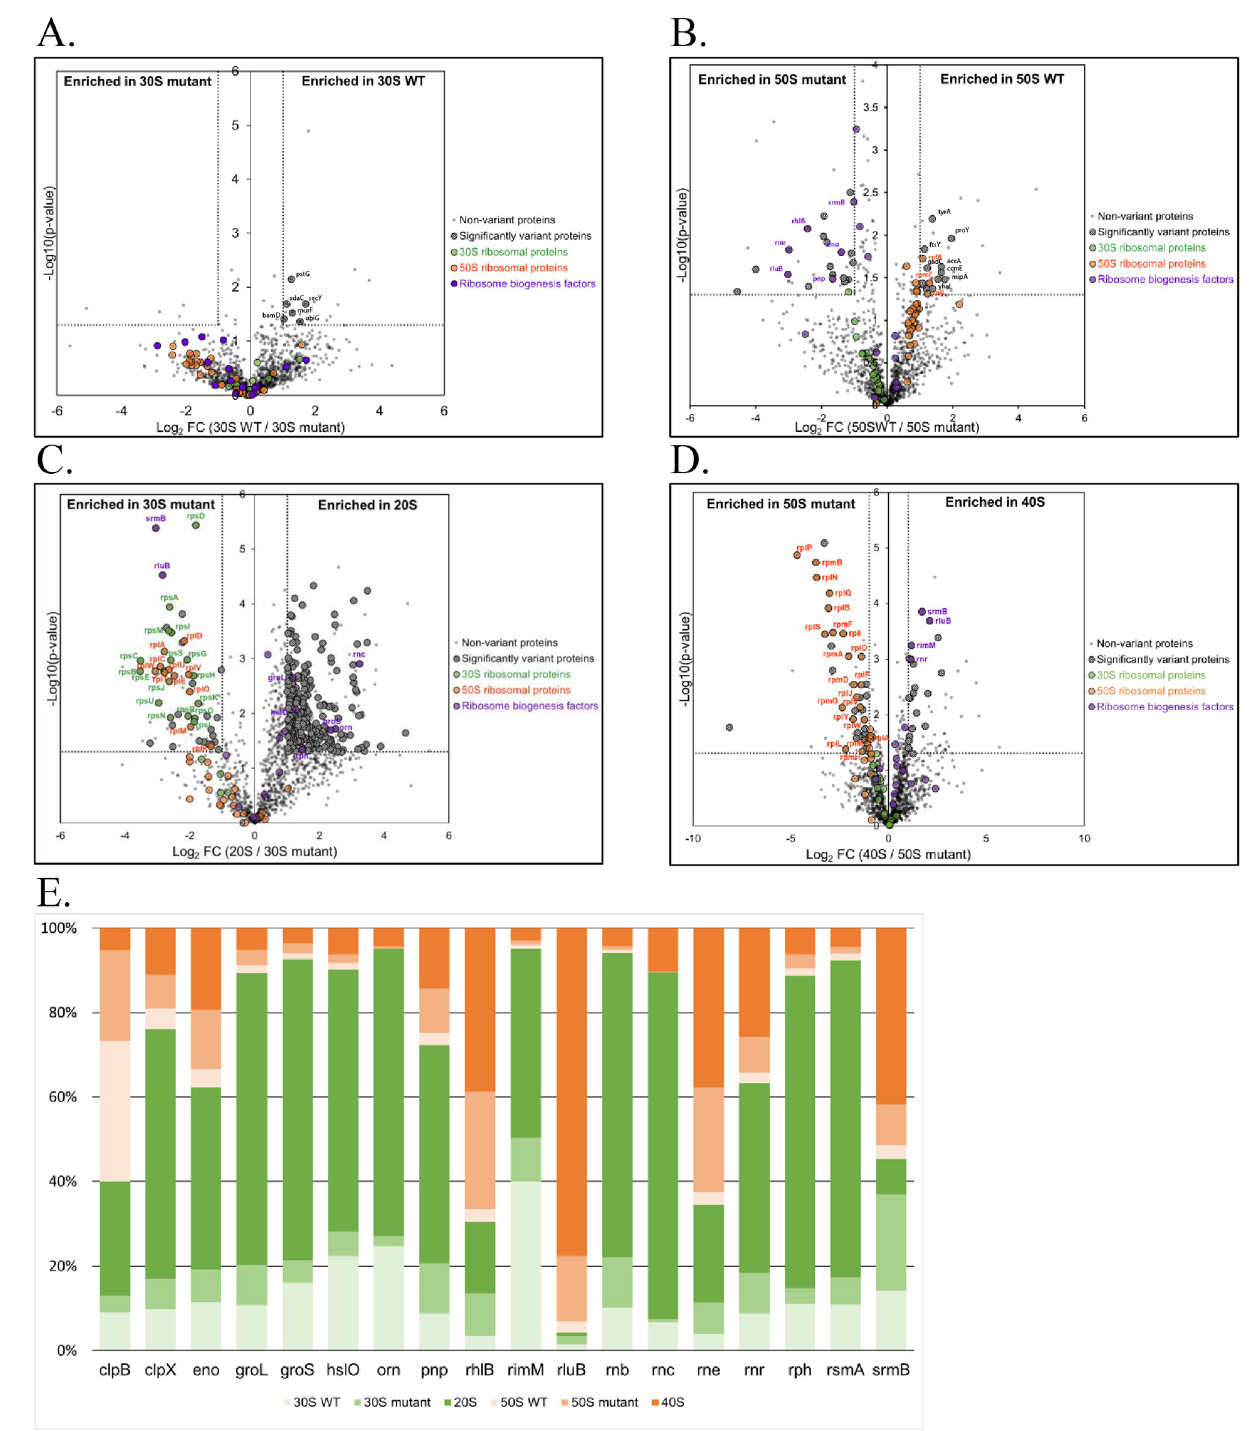
Fig 6. Protein composition of aberrant intermediates in ribosome assembly. Protein content of the ribosomal particles from rne + and rne Δ MTS strains. Extracted proteins from sucrose gradient fractions were identified and quantified using a label-free quantitative mass spectrometry approach. Volcano plots showing significantly variant proteins (striped plots) in 30S particles from rne + versus rne Δ MTS strains ( A ), in 50S particles from rne + versus rne Δ MTS strains ( B ), in 20S versus 30S particles from rne Δ MTS strains ( C ), and in 40S versus 50S particles from rne Δ MTS strains ( D ) are presented. An unpaired bilateral Student t test with equal variance was used. Variant significance thresholds are represented by an absolute log2-transformed fold-change (FC) greater than 1